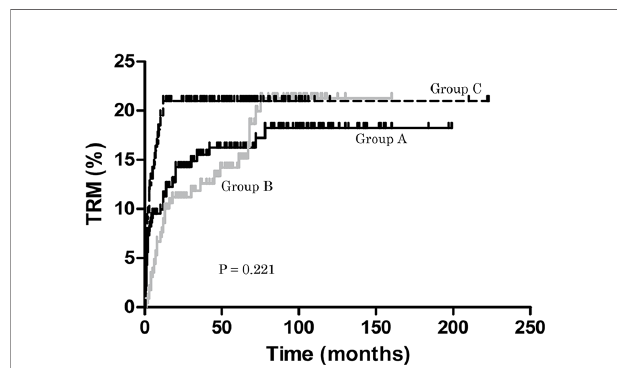
FIGURE 1 | Treatment-related mortality (TRM). During the follow-up period, TRM in groups A, B and C was 18.25%, 21.25% and 20.98%, respectively ( P = 0.221).